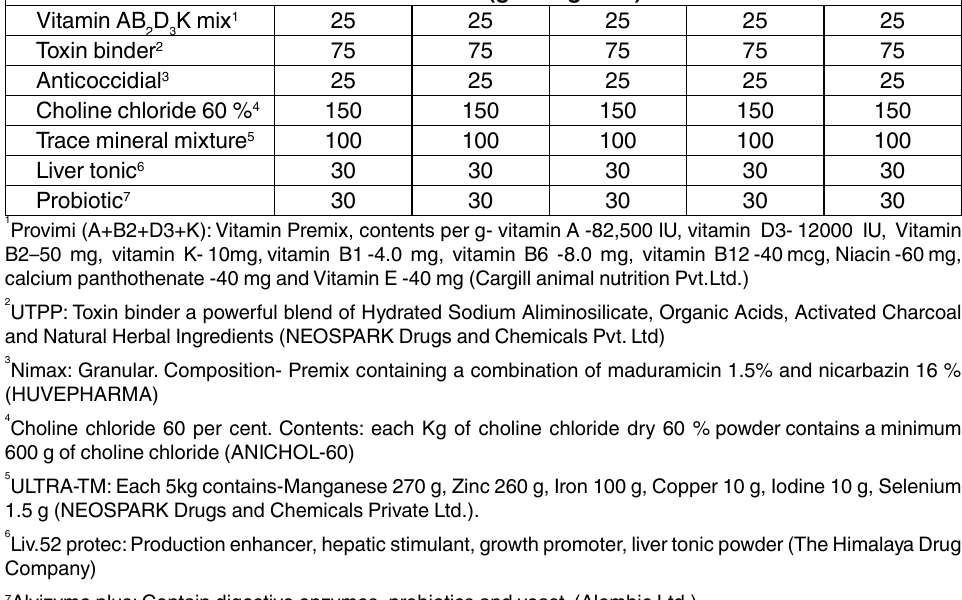
table 3. Analysed per cent chemical composition of experimental ration (On dry matter basis) Parameter Dry matter 90.60 Crude protein Crude fibre Ether extract Total ash Acid insoluble ash Calcium